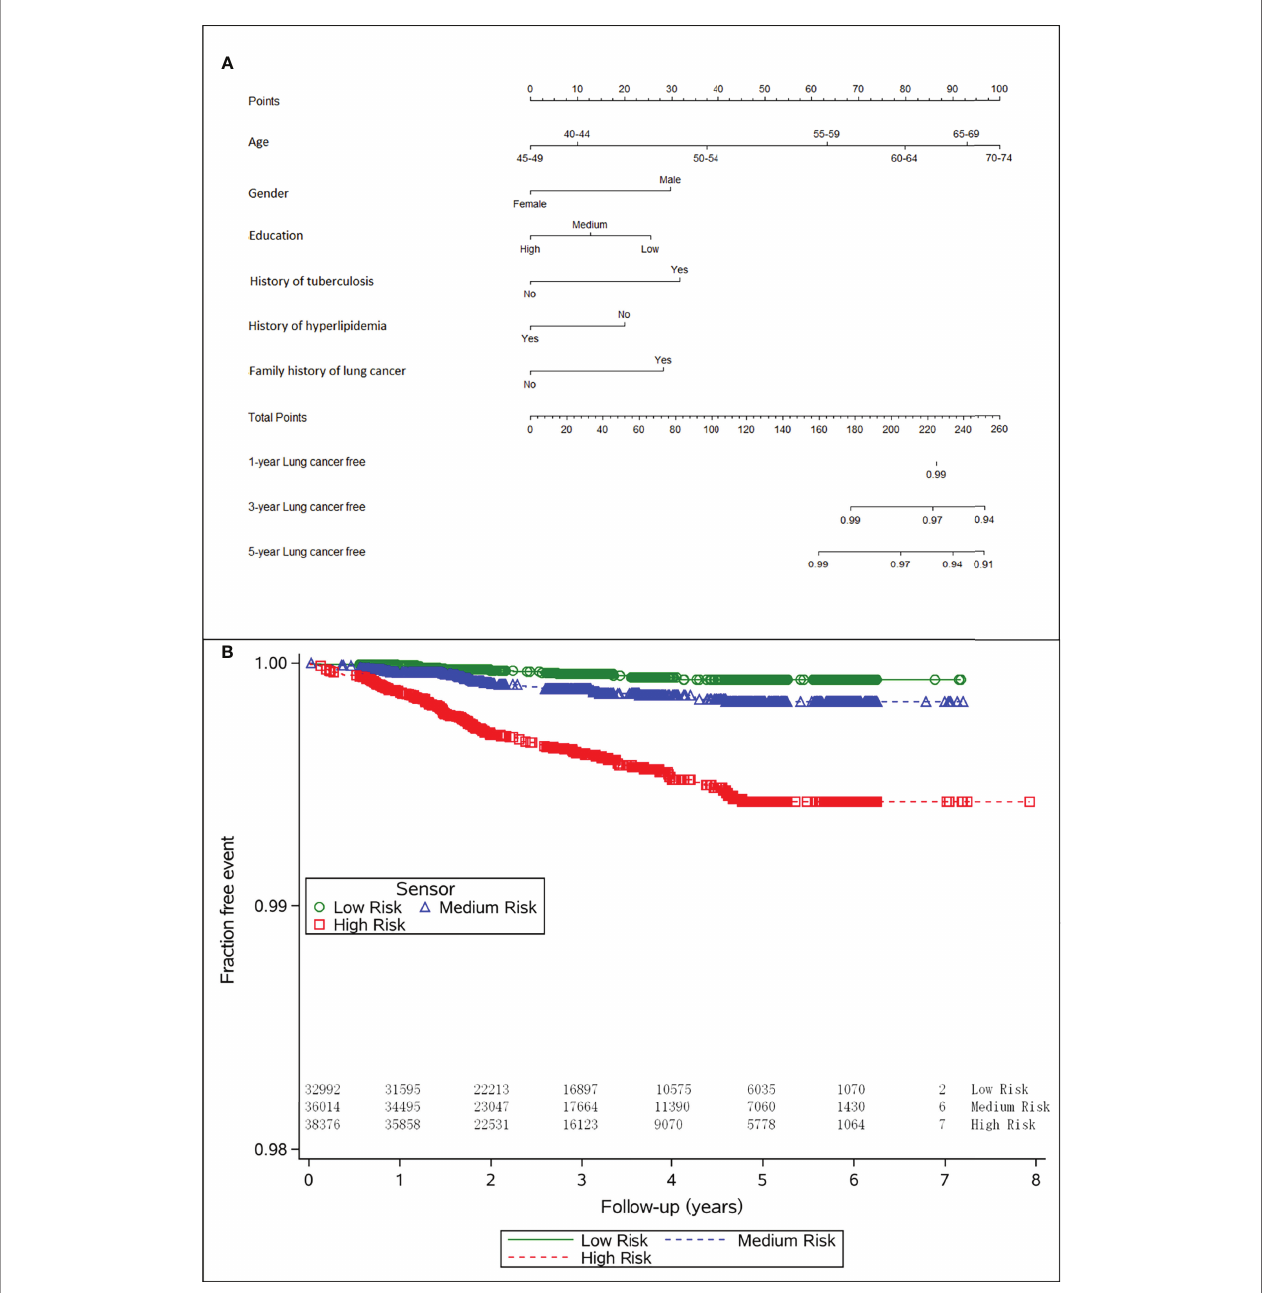
FIGURE 2 | (A) Nomogram to calculate the personal 1-, 3- and 5-year risk of lung cancer risk, and (B) the lung cancer incidence across different cancer risk